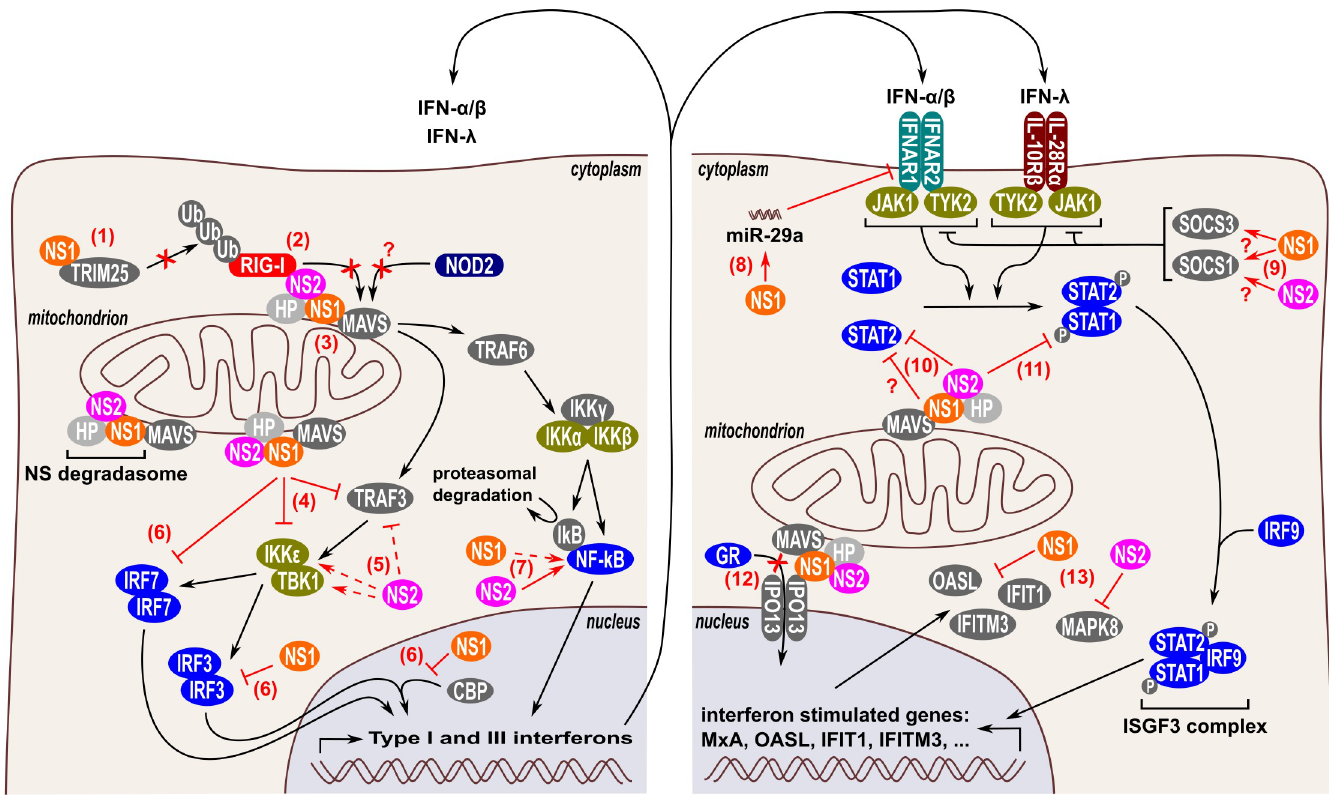
Fig 2. RSV NS1 and NS2 effector functions that can suppress IFN responses. Type I and III IFN responses are inhibited by NS1 and NS2 at multiple levels, both during the induction of type I and III IFNs (left panel) and during IFN-induced signaling (right panel). NS1 and NS2 can form a so-called “NS degradasome” complex that is stabilized by mitochondria via MAVS. The NSD complex is thought to contain HPs, including the proteasome α 2 subunit and other as yet unidentified proteins. NS1 and NS2 prevent the interaction of RIG-I with MAVS in different ways. NS1 binds to the PRY-SPRY domain of TRIM25, which is responsible for the interaction of TRIM25 with RIG-I. As such, NS1 prevents the TRIM25-mediated K63-linked polyubiquitination of RIG-I, which is necessary for the subsequent interaction of RIG-I with MAVS (1). Moreover, NS2 directly interacts with RIG-I (2) and NS1 interacts with MAVS (3) to suppress binding of RIG-I to MAVS. Whether the interaction of NS1 with MAVS also prevents the interaction of NOD2 with MAVS is currently unclear. NS1 reduces protein expression of TRAF3 and IKK ε (4), whereas NS2 modestly reduces TRAF3 and induces IKK ε and TBK1 (5). NS1 subsequently inhibits IRF3 and IRF7 by different proposed mechanisms (6). NS1 reduces IRF3 and IRF7 protein expression and prevents the interaction between IRF3 and CBP, thereby lowering the binding of the IRF3-CBP complex to the IFN- β promoter. NS2, and to a lesser extent NS1, enhances the activation and nuclear translocation of NF- κ B (7). These NS1/NS2 effector functions (1–7) synergistically reduce the production of type I and III IFNs. Furthermore, NS1 and NS2 also suppress type I and III IFN receptor-mediated signal transduction. NS1 induces miR-29a expression, which targets the mRNA coding for IFNAR1, one of the 2 subunits of the type I IFN receptor (8). NS1 and NS2 may induce expression of SOCS proteins (SOCS1 and 3), which negatively regulate the tyrosine kinases JAK1 and TYK2, which are important to transmit signaling from the type I and III IFN receptors (9). NS2 inhibits JAK1/ TYK2-mediated activation of STAT1/2 by reducing STAT2 protein levels (10) and by reducing STAT1 phosphorylation (11). Some groups, however, reported that STAT2 expression can also be reduced by NS1 (see text) (10). NS1 and NS2 counteract the anti-inflammatory activity of the GR, although the exact mechanism is debated. In one model, NS1 interacts with the nuclear translocator IPO13, which competes with GR for its nuclear translocation (12). Recent evidence suggests that